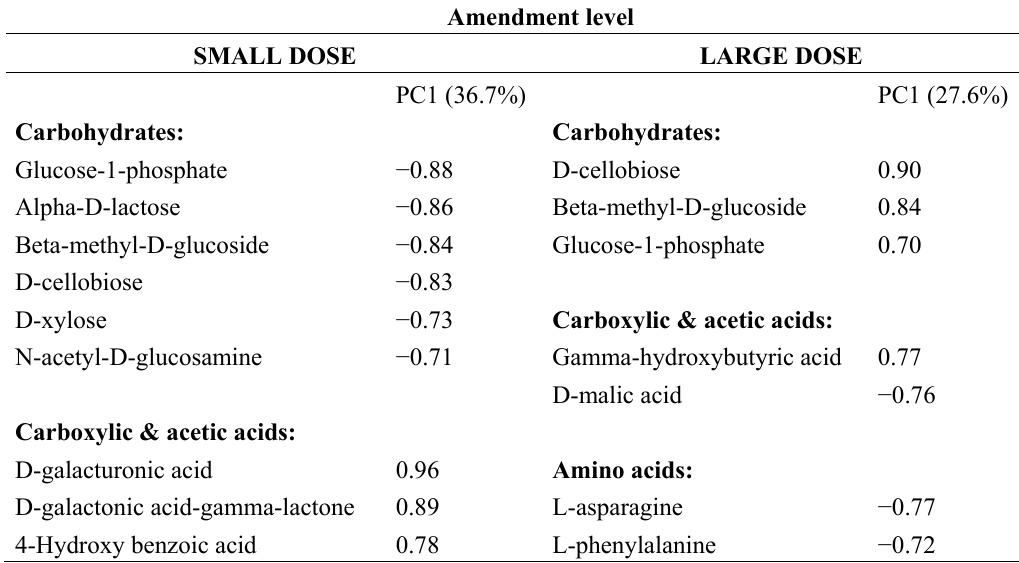
Table 4. Correlation of carbon sources with the first principal component (PC1) in soil treated with two different doses of amendments (R >